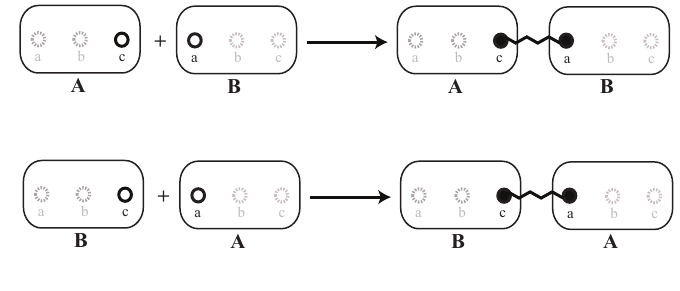
Figure 4. Examples of implicit reaction rules. Illustrative presentation of different rules between two molecules. Both displayed rules describe an interaction between the elementary molecules , A and B . The difference is in the participating sites . This example could lead to a double connection between A and B if there were no steric restraints. Another possibility is the formation of polymers of indefinite length. Please note that the binding sites in grey are not part of the rule, i.e. , the bond and modification state of the grey sites is not considered for the rule to be applicable. All that is required for the upper rule to fire is that a molecule, A , has a free binding site, c , and that a molecule, B , has a free binding site, a . Then, these free binding sites are bound together. Via the grey binding sites, large molecule graphs could be connected, which would not interfere with the reaction.